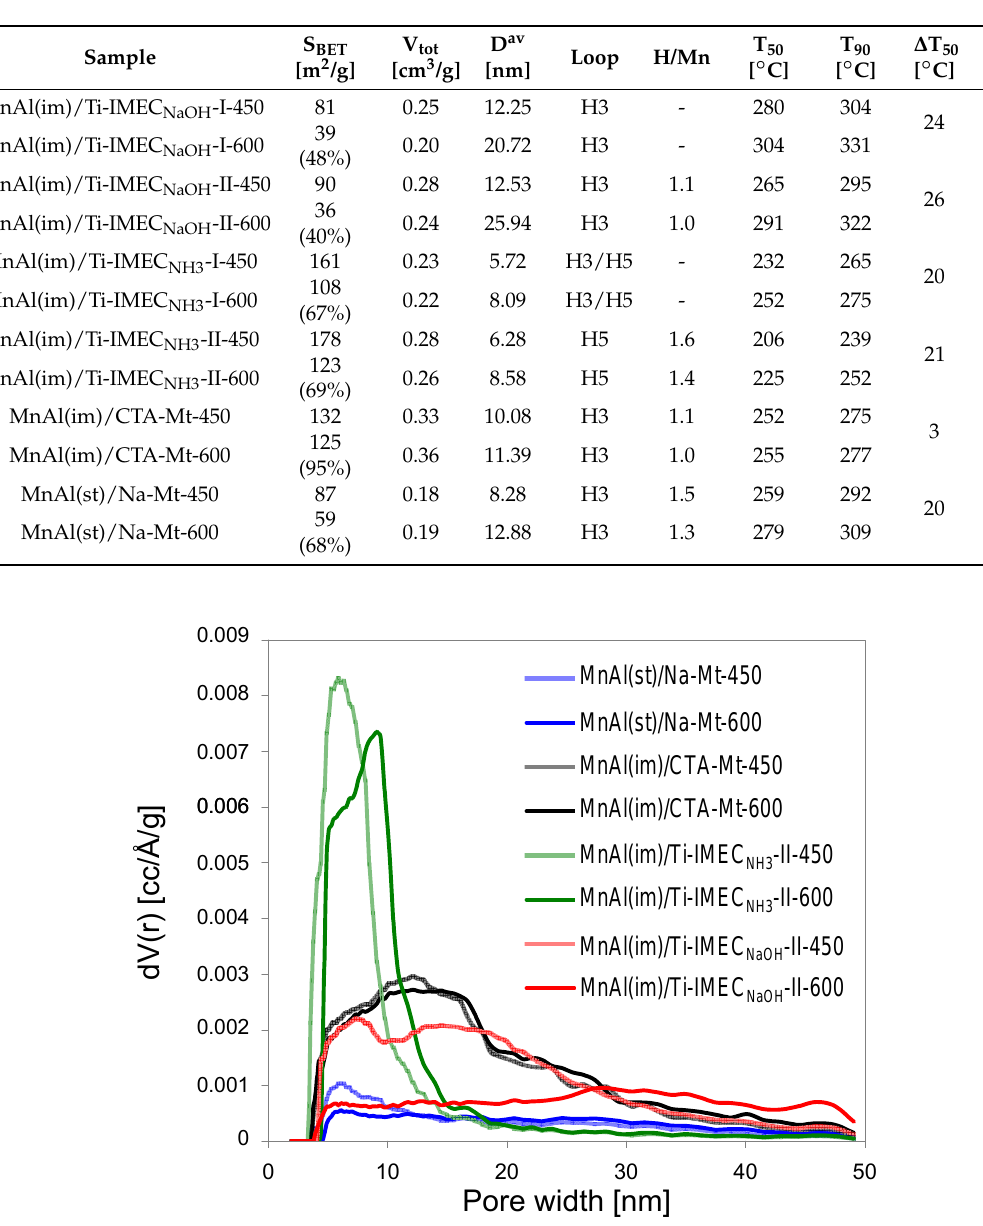
Table 2. S BET —specific surface area (in brackets % of the 450 ◦ C specific surface retained at 600 ◦ C), V tot —total pore volume, D av —average pore diameter, type of hysteresis loop, H/Mn—hydrogen consumption from TPR experiments, T 50 —temperature of 50% conversion, T 90 —temperature of 90% conversion, ∆ T 50 —difference between T 50 after calcination at 600 and 450 ◦ C, and ∆ T 90 —difference between T 90 after calcination at 600 and 450 ◦ C.